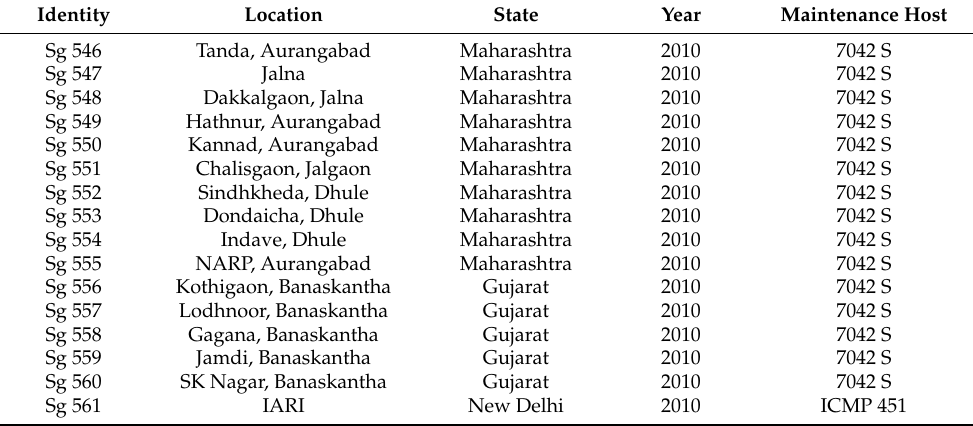
Table 1. Cont. Identity